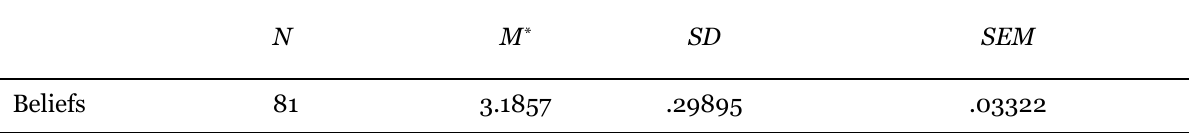
Descriptive Statistics of a General Nature of English Teachers’ Beliefs in the Use of Smartphones for